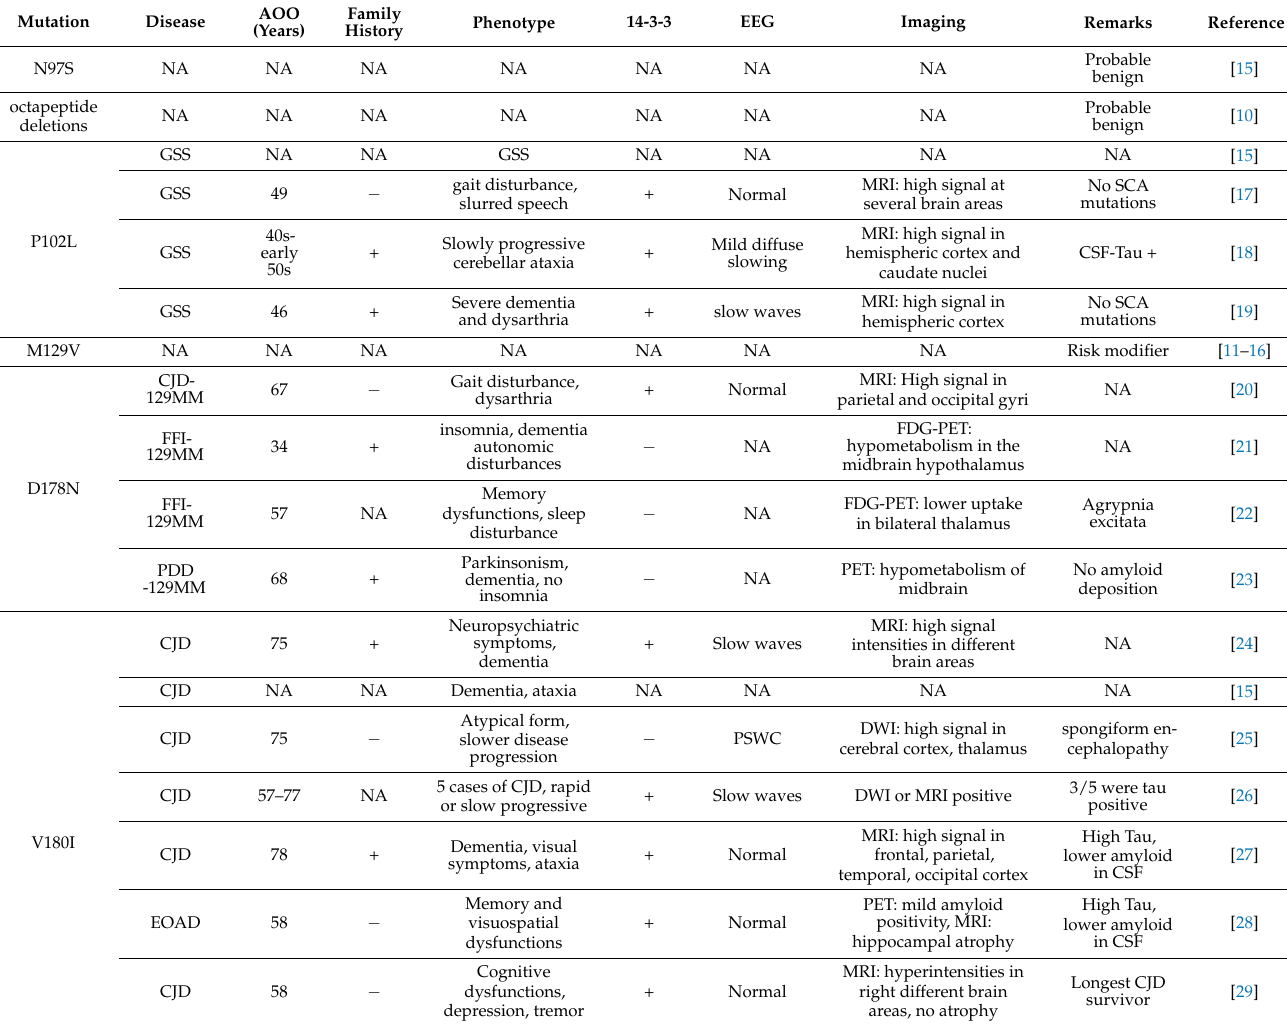
Table 1. Prion mutations found in Korean patients (AOO means age at onset, EEG means electroen-